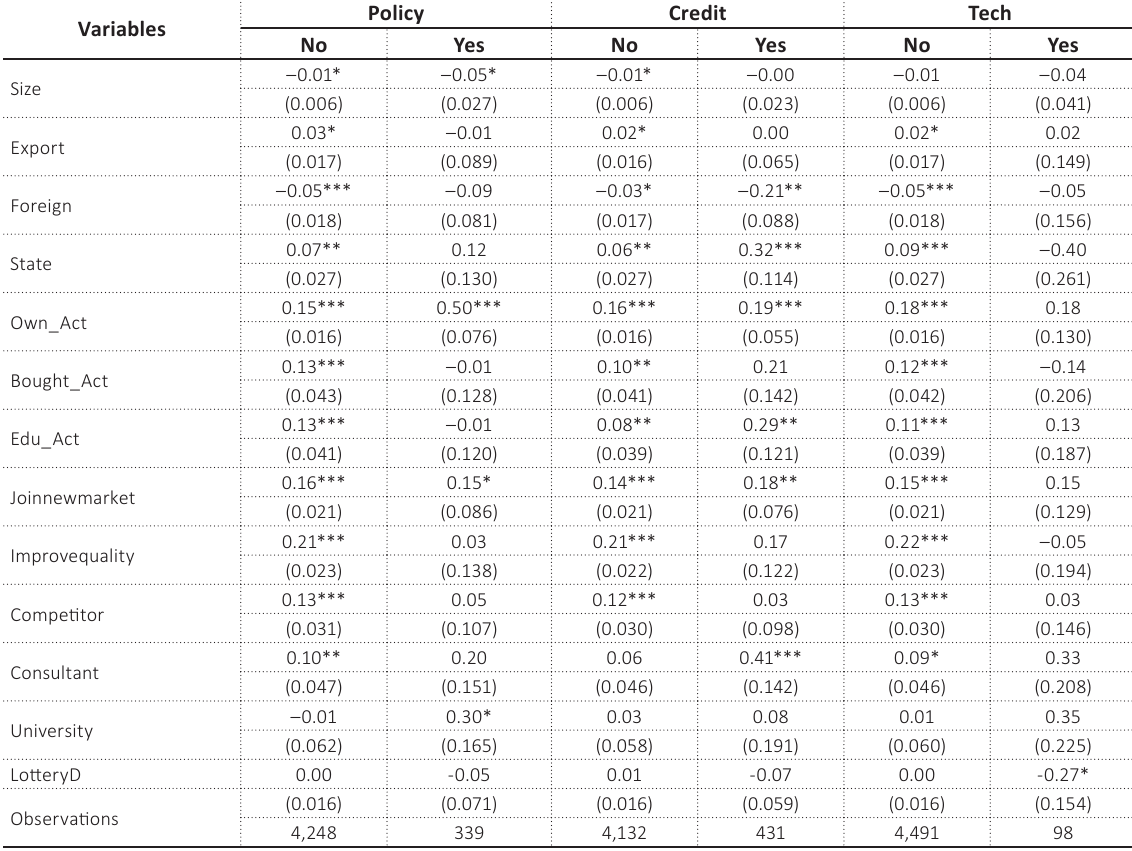
Table 4. The mediating role of government support by types of government support